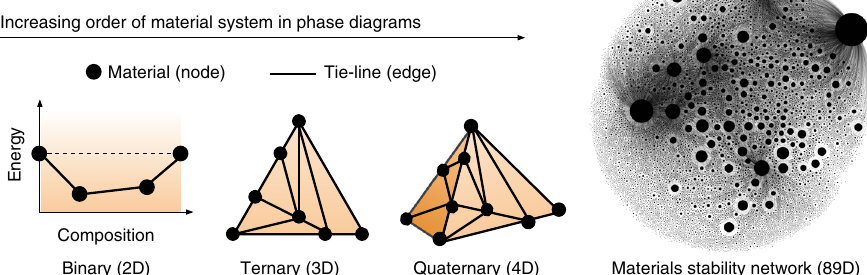
Fig. 1 Network representation of material phase diagrams. The schematic illustrates phase diagrams with the order of the system ranging from two- dimensional binary to the 89-dimensional materials stability network central to this work. The energy-composition convex-hull is shown for the binary system, and all higher-order phase diagrams are projections of their respective N -dimensional convex-hulls to two dimensions, where materials are represented as nodes and tie-lines as edges. For clarity, only those tie-lines connected to high-degree nodes are shown in the materials stability network, where the sizes of the nodes are also scaled to re fl ect their degree